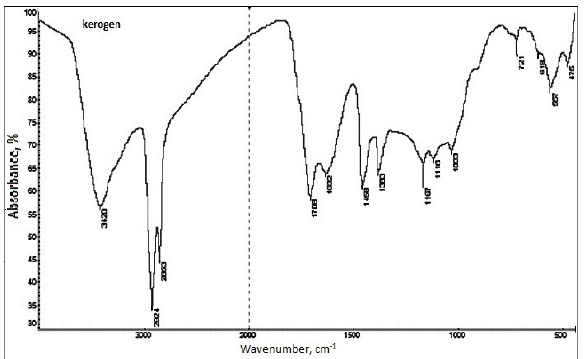
Fig. 2. IR spectrum of kerogen in Uvurjargalant oil shale